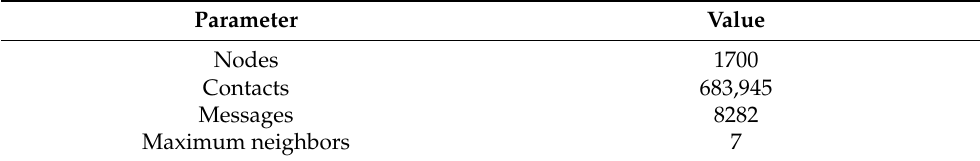
Table 4. Wi-Fi Direct trace output